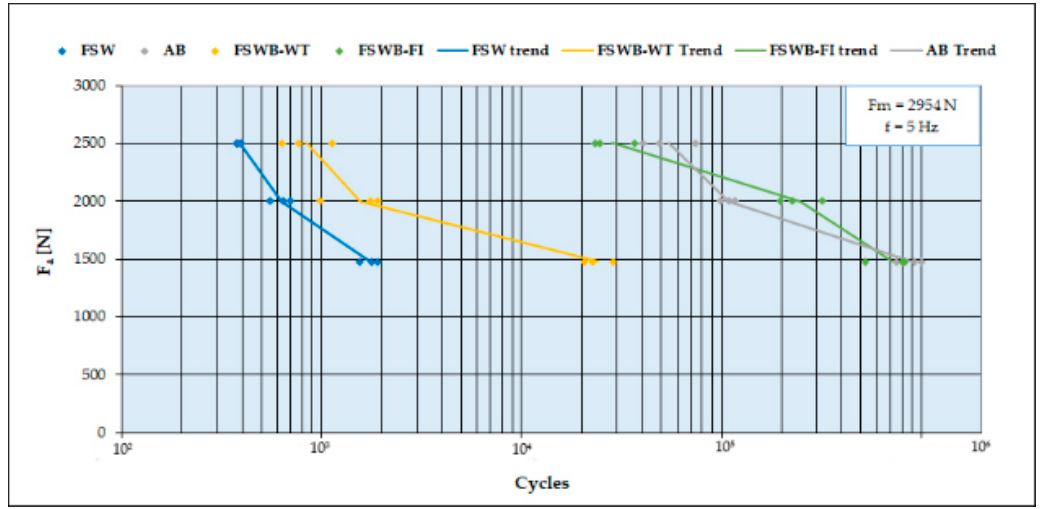
Figure 7. Fatigue resistance comparison between FSW, FSWB (weld-through and flow-in methods) and